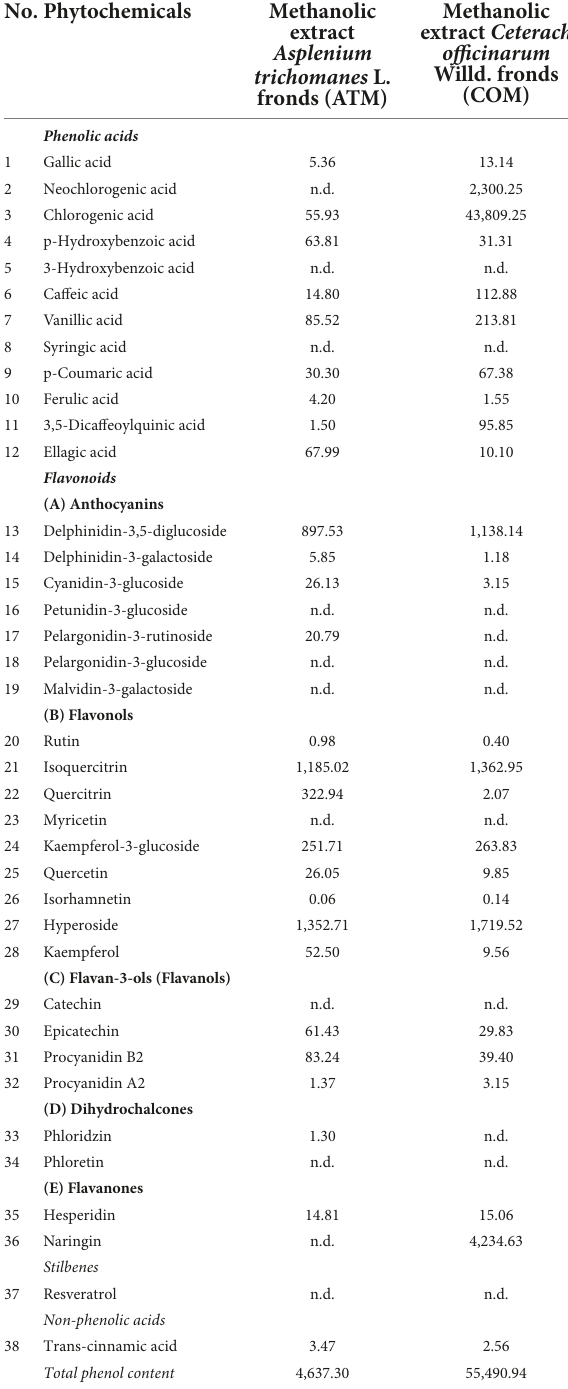
TABLE 1 Content (mg/kg of dry extract) of 38 polyphenolic phytochemicals in the methanolic extract of Asplenium trichomanes L. and Ceterach officinarum Willd. fronds.